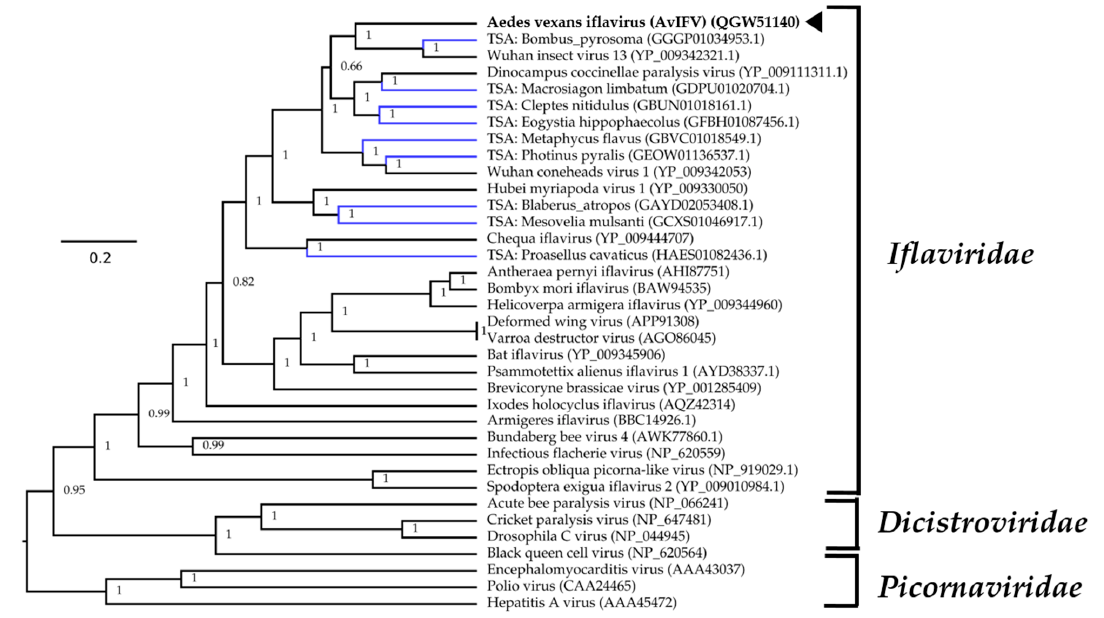
Figure 2. Maximum clade credibility tree of AvIFV within the Picornavirales order. Phylogenetic inferences were calculated using Bayesian evolutionary analysis sampling trees (BEAST v2.5.1) with polyprotein alignments using the Whelan and Goldman protein substitution model with a chain length of 10 × 10 6 . A black arrowhead indicates AvIFV and Genbank accession number is in parentheses. Putative viruses identified in the Transcriptome Shotgun Assembly are labelled in blue. The tree is rooted arbitrarily on the Picornaviridae outgroup. Branch length indicates the number of substitutions per site.